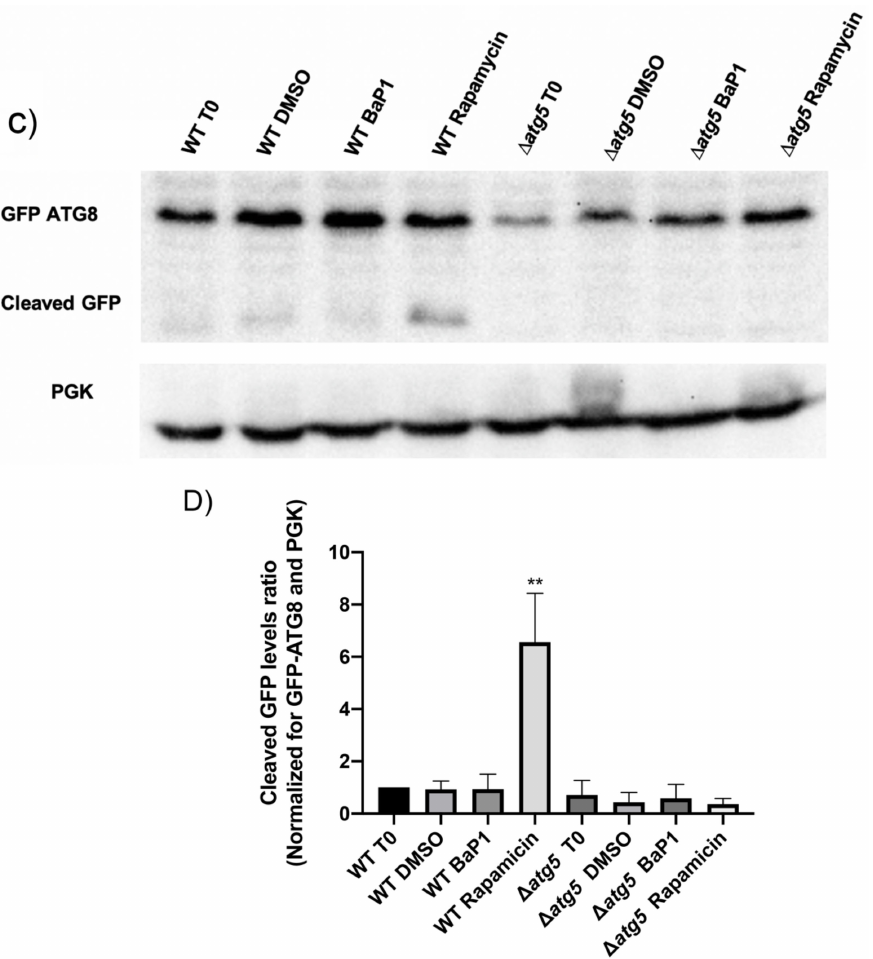
Figure 4. Evaluation of autophagy induction. ( A ) Effect of BaP1 (300 µ M) and DMSO (0.35%) on cell viability of S. cerevisiae W303-1A and W303-1A ∆ atg1 . ( B ) Fluorescence microscopy images of W303-1A GFP-ATG8 and W303-1A ∆ atg5 GFP-ATG8 cells after 60 min treatment with BaP1 (300 µ M) or DMSO (negative control), and Rapamycin (0.2 µ g/mL). Samples were collected at different time points, before (time 0) and after 30, 60, 90, and 120 min of treatment, and then observed by epifluorescence microscopy with a 100 × oil immersion objective. ( C ) Effect of BaP1 or DMSO (negative control), and Rapamycin (positive control) on the Atg8p processing of W303-1A GFP-ATG8 and W303-1A ∆ atg5 GFP-ATG8 cells. Representative experiment of two independent experiments. ( D ) Quantification of cleaved GFP, values are ratios, normalized for GFP-ATG8 protein levels and PGK levels. Values are the means with SD ( n ≥ 2). Statistical analysis was performed by two-way ANOVA. ns: non-significant, ** p <